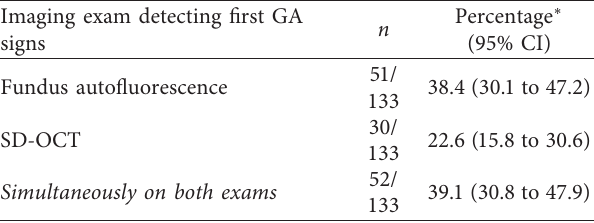
Table 1: Percentage of drusen showing incipient atrophy of the retinal pigment epithelium detected first with each imaging